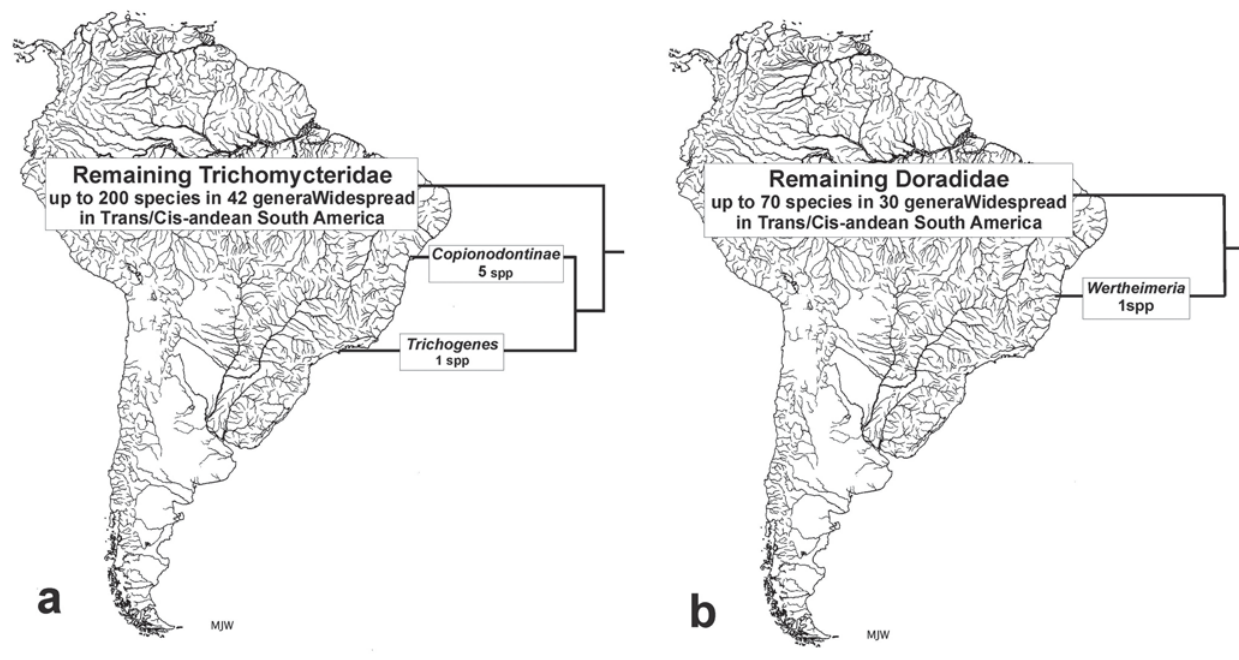
Fig. 9 . Cladograms of taxa and areas showing the sister-group relationships included in Pattern A. a) Catfishes of the family Trichomycteridae. b) Catfishes of the family Doradidae. The degree of inclusiveness of this pattern suggests the most ancient cladogenetic event that is still recognized in respect to the ichthyofauna of the Brazilian coastal rivers.